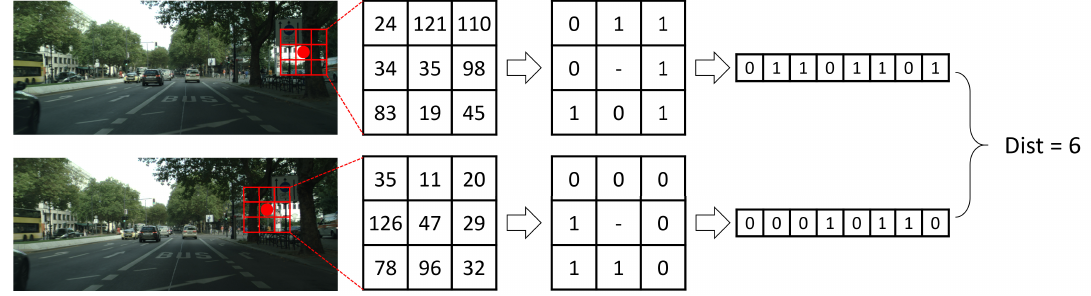
Figure 2. Example of Census cost. The similarity is measured by Hamming